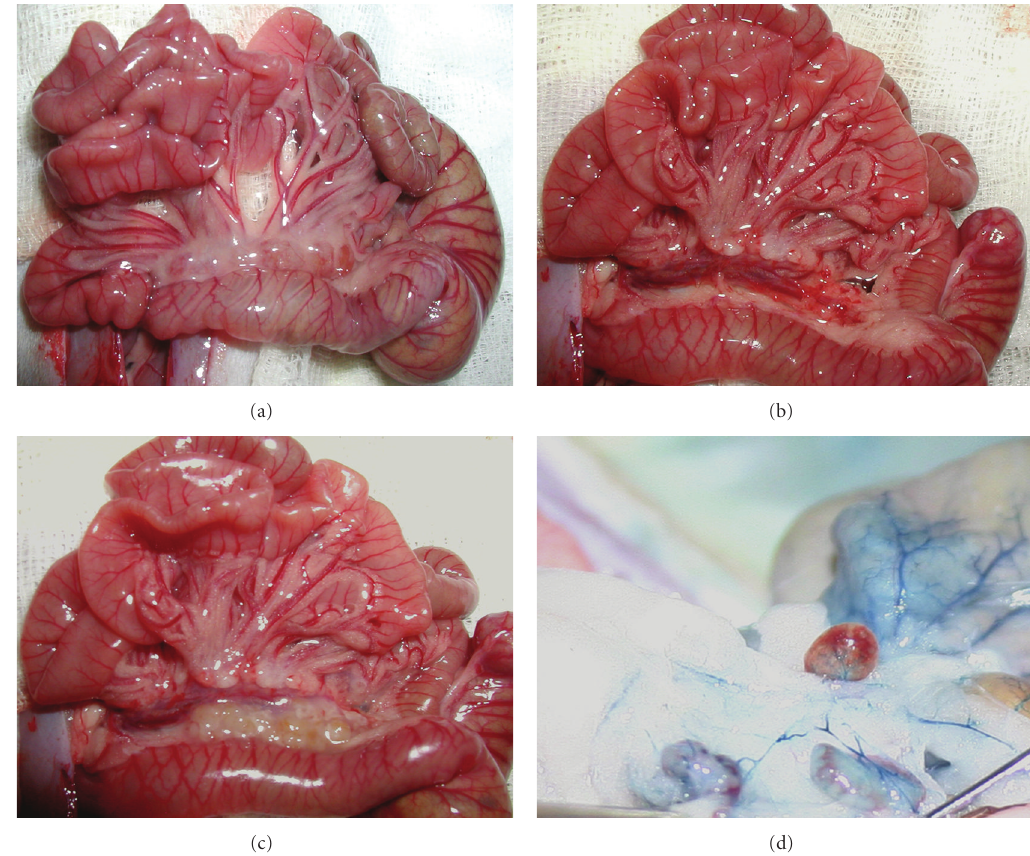
Figure 1: The gut system with mLN during operation and after regeneration. Rats were anesthetized and the abdomen was opened. The gut was taken out and the mLN were seen (a). The mLN were removed carefully (b). Afterwards the donor LN were placed in the vacant area (c). The gut was replaced in the abdomen and the abdomen closed. After 8 weeks LN were analyzed by injecting a dye (Berlin blue) which is transported via the lymphatics into the transplanted LN